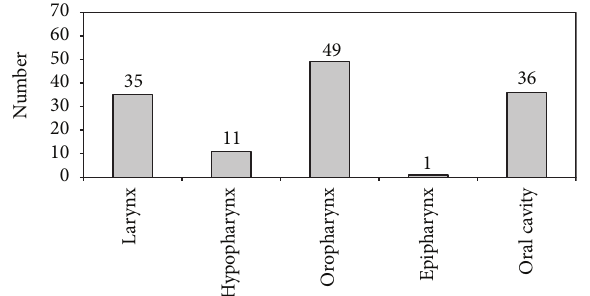
Figure 1: Localization of primary HNSCC in patients screened for the presence of synchronous esophageal pathology by chromoen- doscopy.